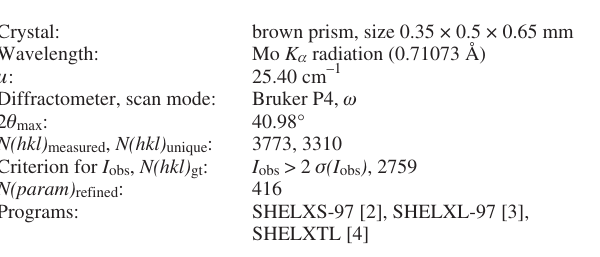
Ni—Brbonds.Thesmallestandgreatestbondangleis (cid:8) N1–Ni2–N2 with 82.8(2) ° and (cid:8) Br1–Ni1–Br2 with 123.5(1) ° . The double bonds of the imino groups are located between N1–C1 and N2–C2 with bond distances of 1.272(8) Å and 1.274(8) Å. The solvent toluene is slightly disordered and was refined without hydrogen atoms.